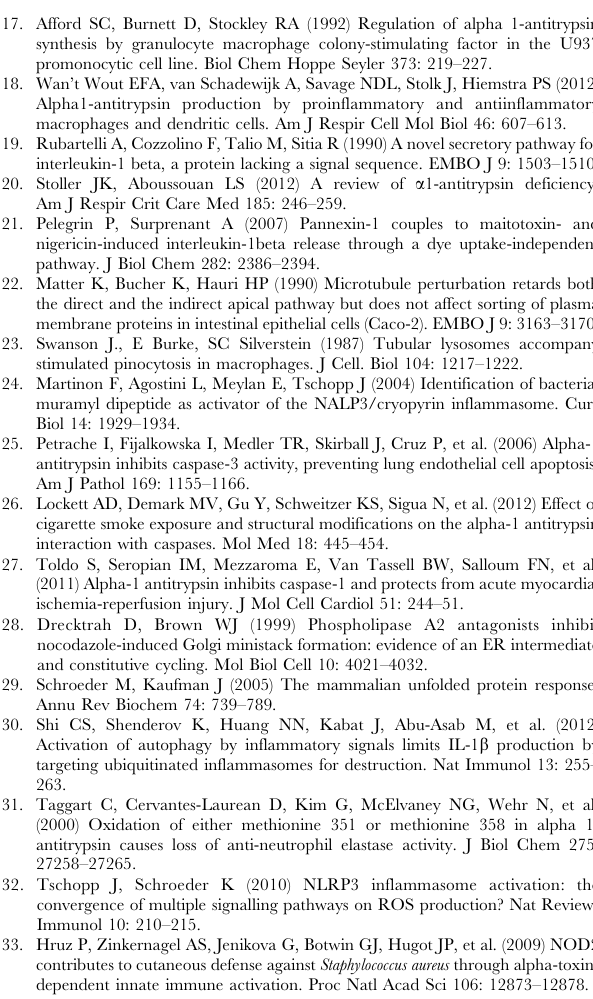
Figure S3 Cytosolic A1PI is Detected after Endocytosis Inhibition in Primary Peripheral Blood Monocytes. Primary elutriated monocytes from healthy adult volunteers were cultured with low or high concentrations of nocodazole plus PMA stimulation for 18 hours. A1PI was detected by immunoblot in cytosolic samples prepared by hypotonic